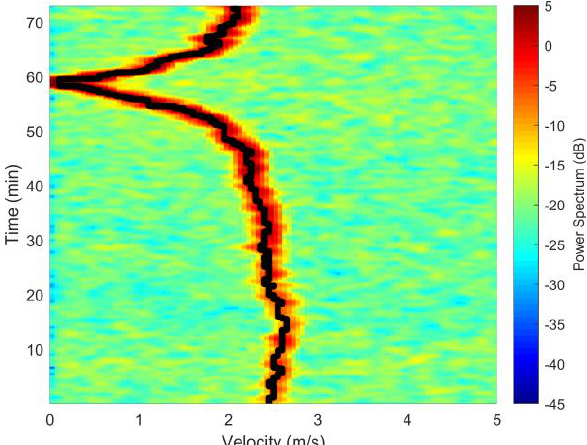
Figure 14. Estimated radial velocities versus time using the broadband method.